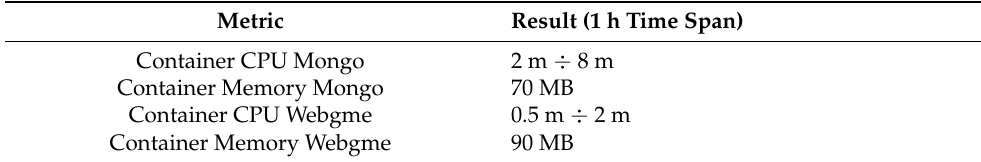
Table 10. Prometheus monitoring results for containers.